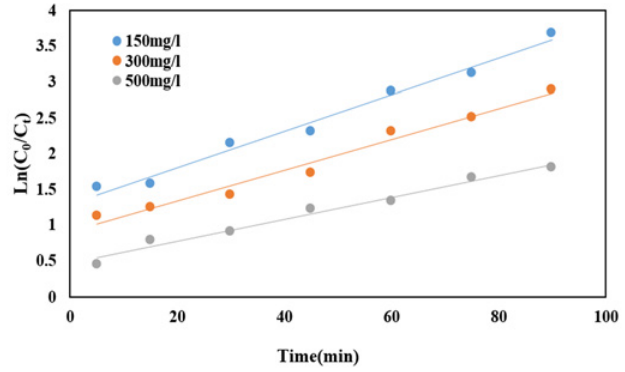
Fig. 7. Photocatalytic degradation kinetics of albumin